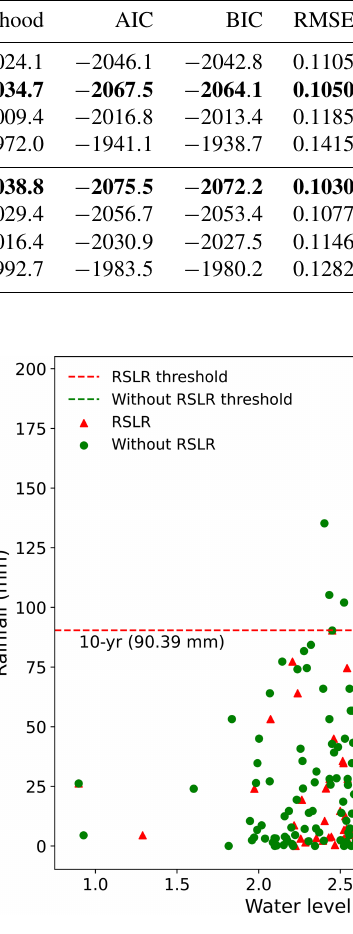
Figure 6. Analysis of a scatter plot of water level and rainfall. Red lines show the design value of the 10-year joint return period with the effect of the RSLR. Green lines show the design value of the 10-year joint return period without the effect of the